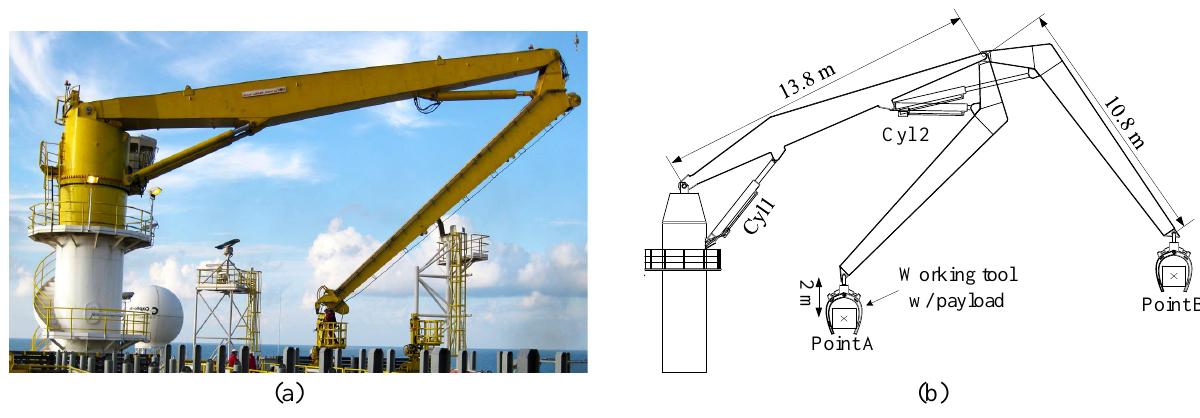
Figure 3: (a) Example of knuckle boom crane with two links provided by National Oilwell Varco c (cid:13) ; (b) Sim- plified drawing of the knuckle boom crane used as a case study. The considered motion trajectory in tool center space is indicated.